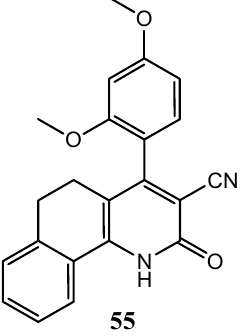
Figure 27. Structure of benzo[ h ]quinoline derivative [125].